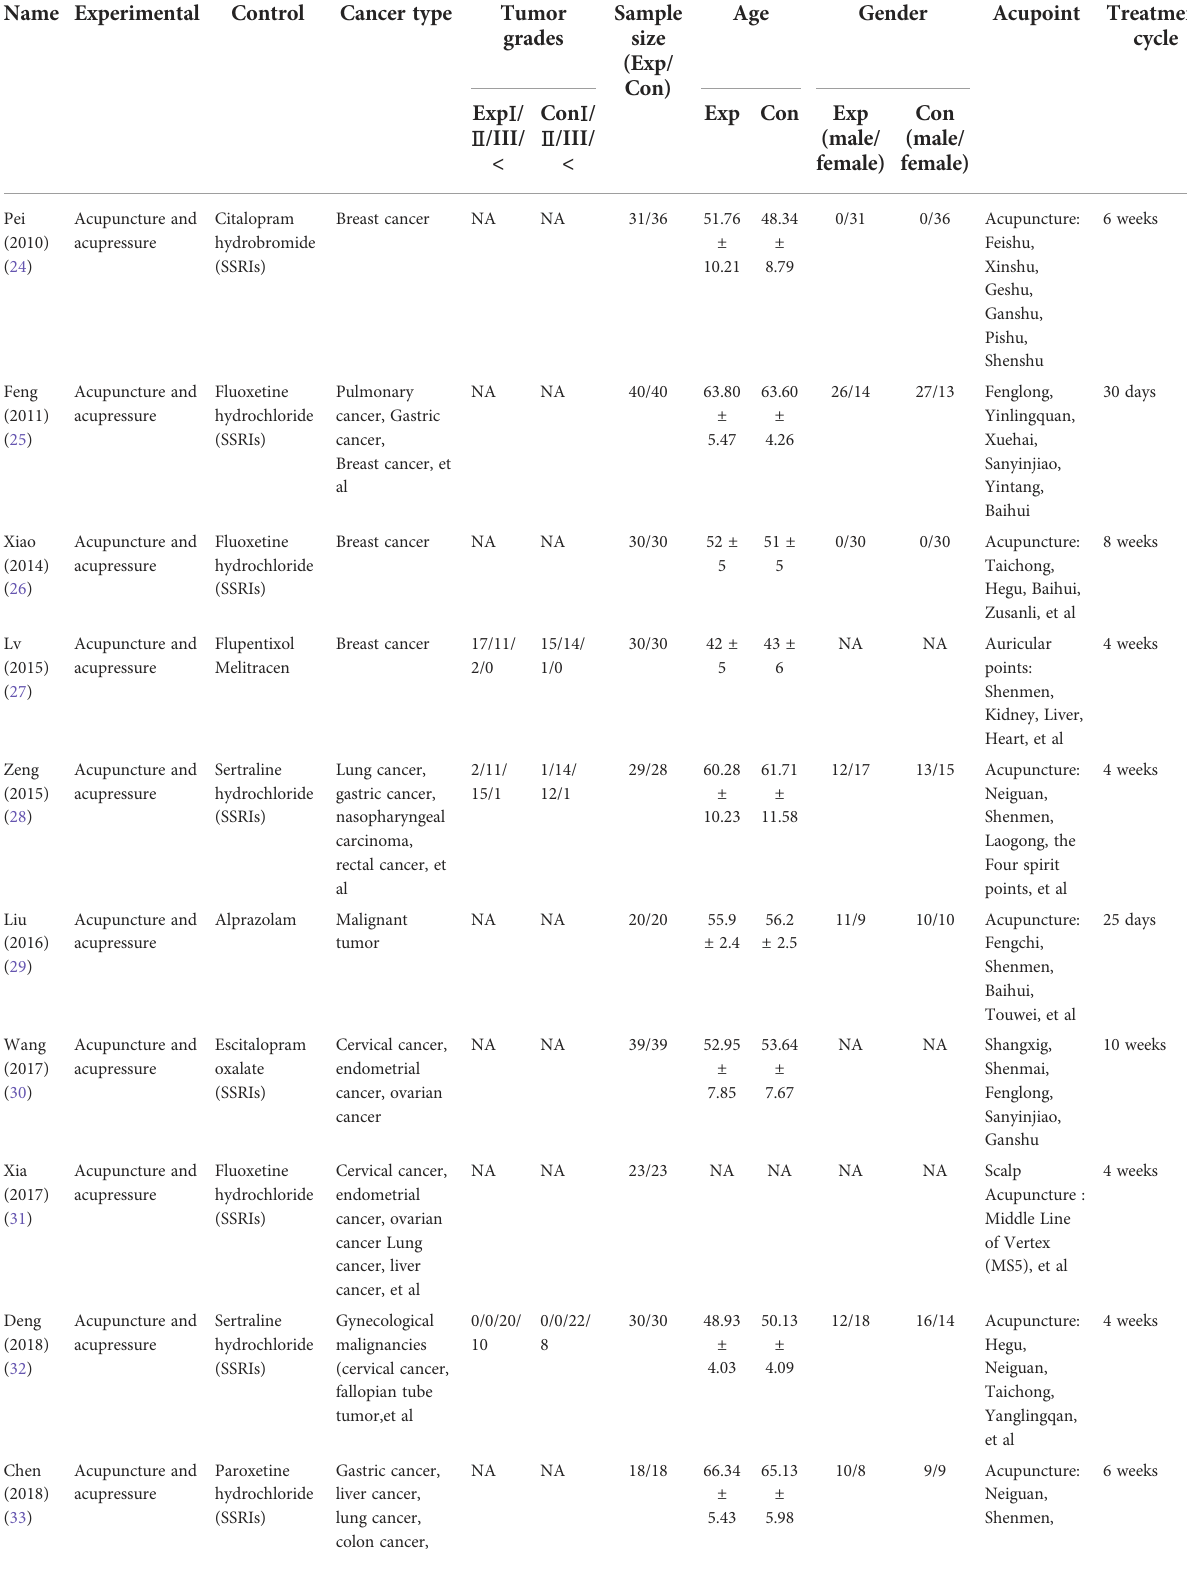
TABLE 1 Characteristics of the included randomised controlled trial studies for Cancer-Related Depression. Name